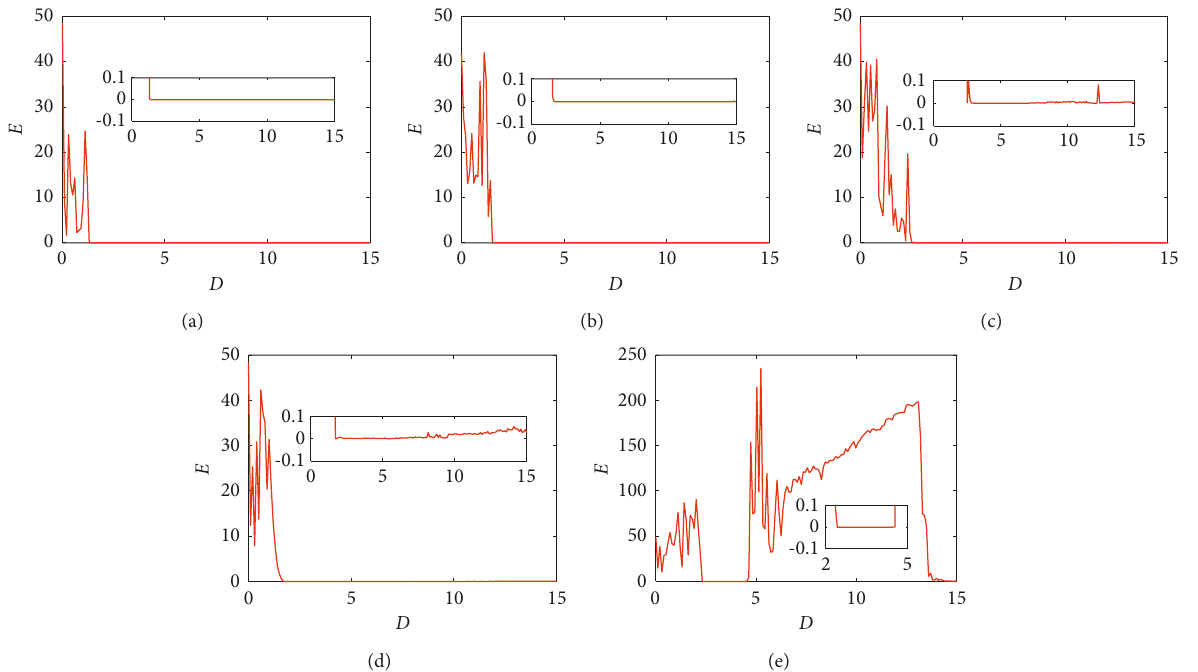
Figure 15: The synchronization errors of the coupled model with respect to coupling strength at case 5 (periodical and spiking neurons). For (a) τ � 0 . 01; (b) τ � 0 . 1; (c) τ � 0 . 3; (d) τ � 0 . 5; and (e) τ � 3. Partially enlarged interval for partial synchronization, and the initial values are selected with (0.1, 0.01, 1.05, 0.1, 0.01,